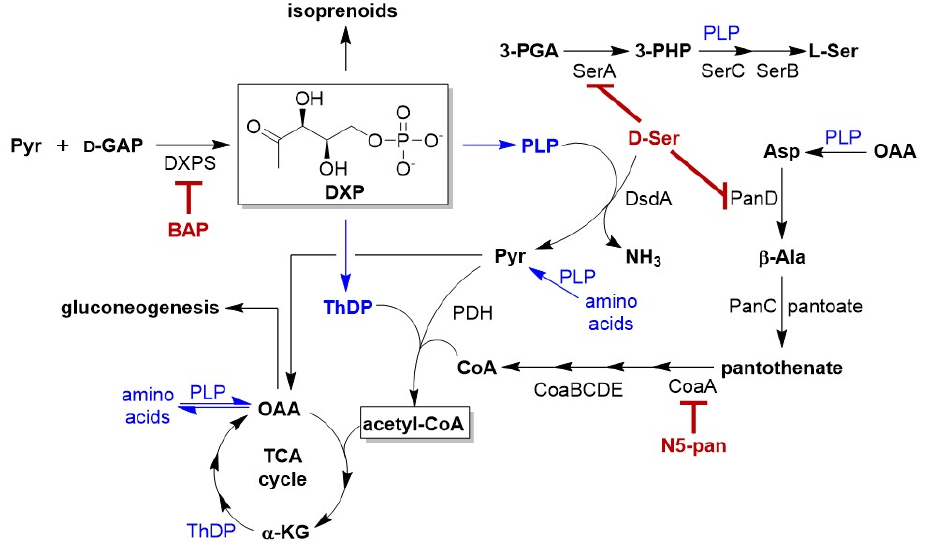
Figure 1. Proposed role of DXPS in UPEC adaptation to D -Ser. Potential metabolic vulnerabilities caused by inhibiting DXPS in the context of UTI include increased sensitivity of UPEC to inhibition of L -serine and/or CoA biosynthesis (red). Metabolic steps involved the TCA cycle or in L -serine/CoA biosynthesis that require PLP or ThDP are highlighted in blue. Abbreviations: acetyl-CoA (acetyl coenzyme A), Asp (aspartate), PanD (aspartate decarboxylase), β -Ala ( β -alanine), CoA (coenzyme A), DXP (1-deoxy- D -xylulose 5-phosphate), DXPS (1-deoxy- D -xylulose 5-phosphate synthase), CoaE (dephospho-CoA kinase), D -GAP ( D -glyceraldehyde 3-phosphate), α -KG ( α -ketoglutarate), OAA (oxaloacetate), PanC (pantothenate synthase), CoaA (pantothenate kinase), 3-PGA (3-phosphoglycerate), SerA (3-phosphoglycerate dehydrogenase), 3-PHP (3-phosphohydroxypyruvate), CoaD (4 (cid:48) -phosphopantetheine adenylyltransferase), CoaB (4 (cid:48) -phosphopantothenoylcysteine synthetase), CoaC (4 (cid:48) -phosphopantothenoylcysteine decarboxylase), SerC (3-phosphoserine aminotransferase), SerB (phosphoserine phosphatase), PLP (pyridoxal 5-phosphate), Pyr (pyruvate), PDH (pyruvate dehydrogenase), D -Ser ( D -serine), DsdA ( D -serine deaminase), L -Ser ( L -serine), ThDP (thiamin diphosphate).